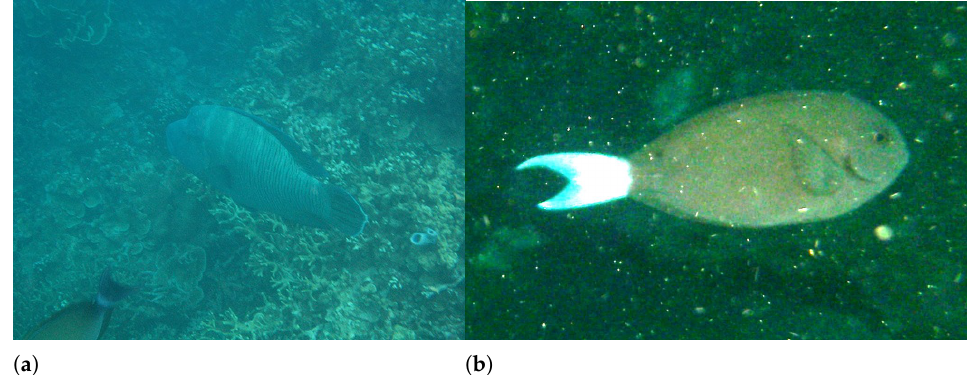
Figure 9. SNPNIQE misjudgment example. ( a ) SNPNIQE(DMOS) = 7.40, ( b ) SNPNIQE(DMOS) =